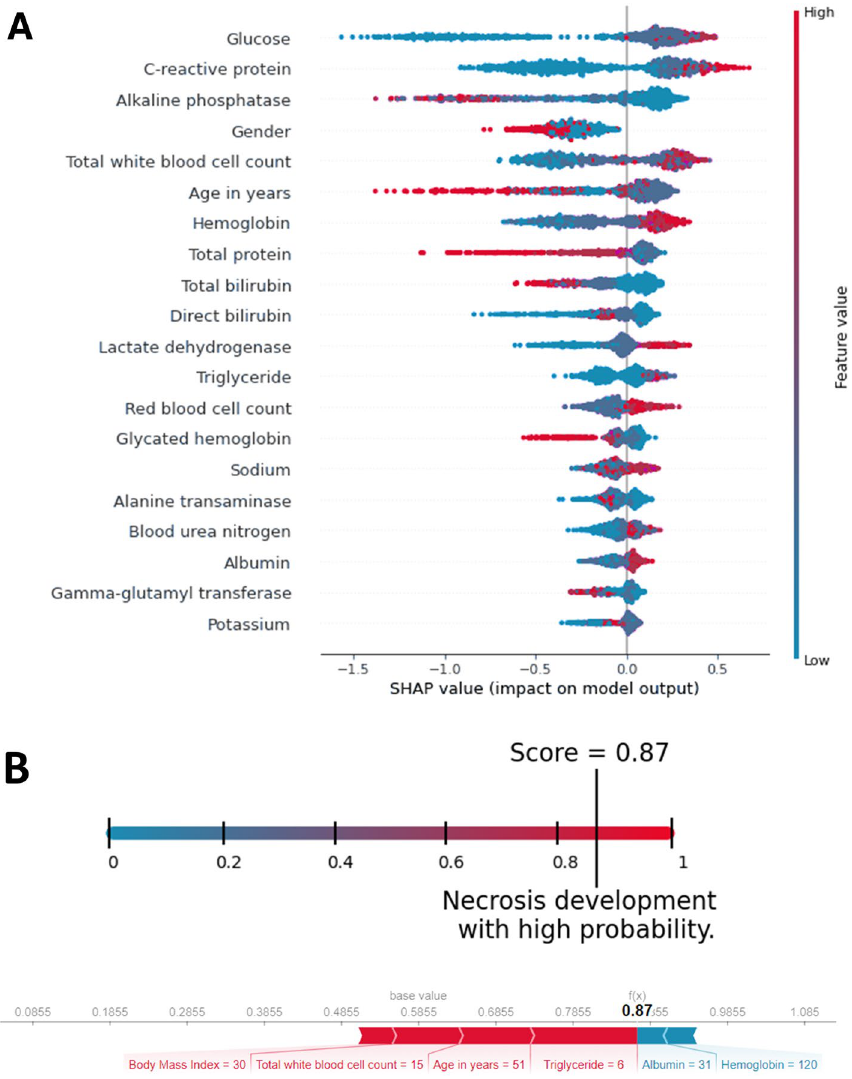
Figure 6. ( A ) The features with the highest impact on model output based on the SHAP values. The higher the predictor is on the list, the bigger the impact on model output. Each patient is represented by a dot. The x-axis represents the extent of the impact on prediction. The color of the dot shows the feature value (e.g. the red color implies higher values). ( B ) An example of prediction and its textual interpretation. The lower picture highlights the effect of individual predictors and the final necrosis probability provided by the